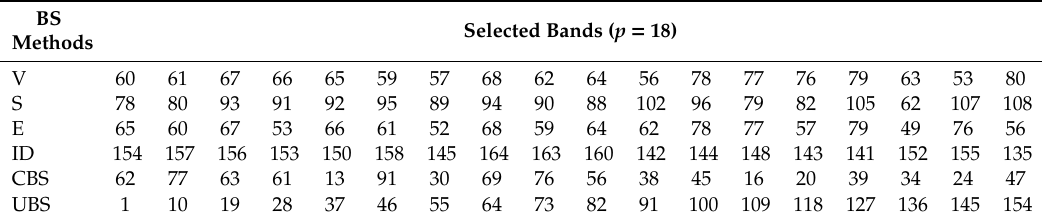
Table 1. The 18 bands selected by variance, signal-to-noise ratio (SNR), entropy, information divergence (ID), and constrained band selection (CBS).